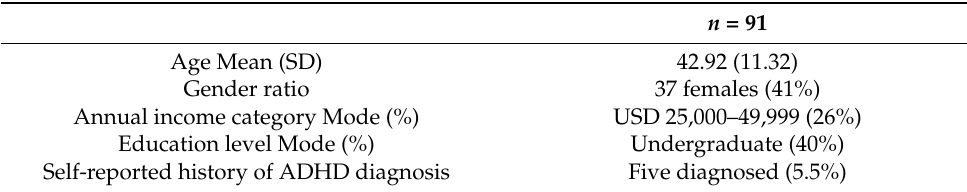
Table 2. Demographic and clinical characteristics, Experiment